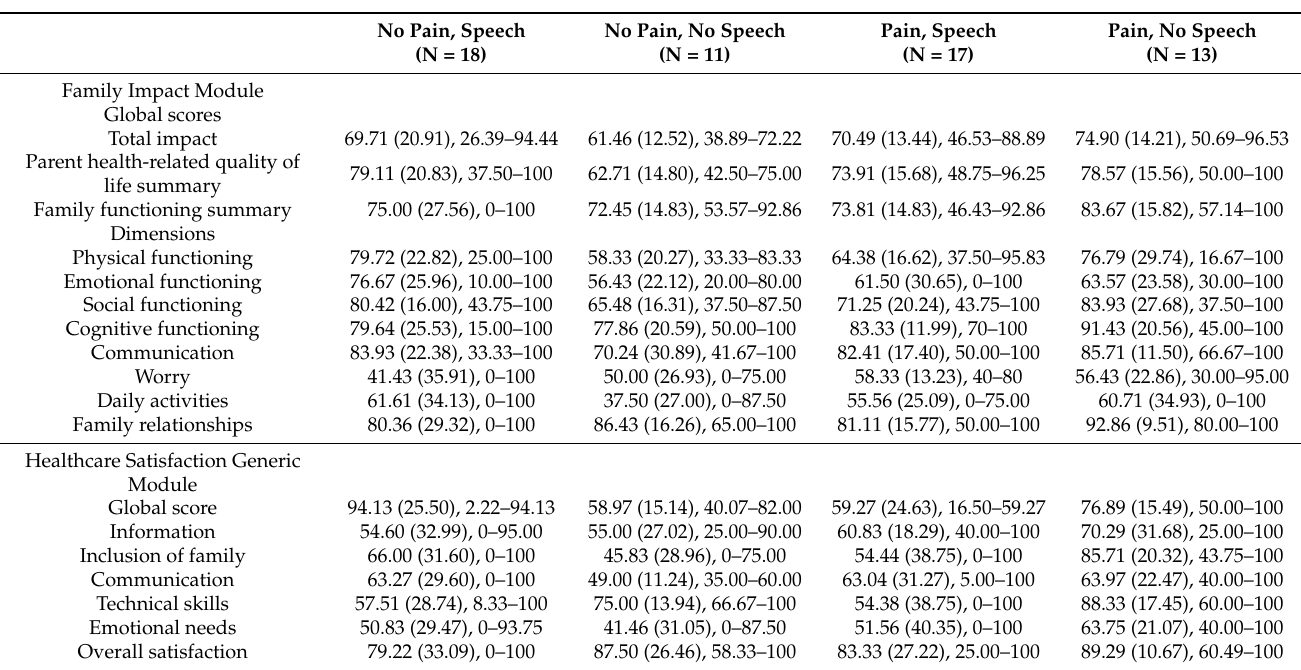
Table 3. Mean (standard deviation) and range of the different domains of the PedsQL TM 2.0 Family Impact Module and the PedsQL TM Healthcare Satisfaction Generic Module in every group of children.